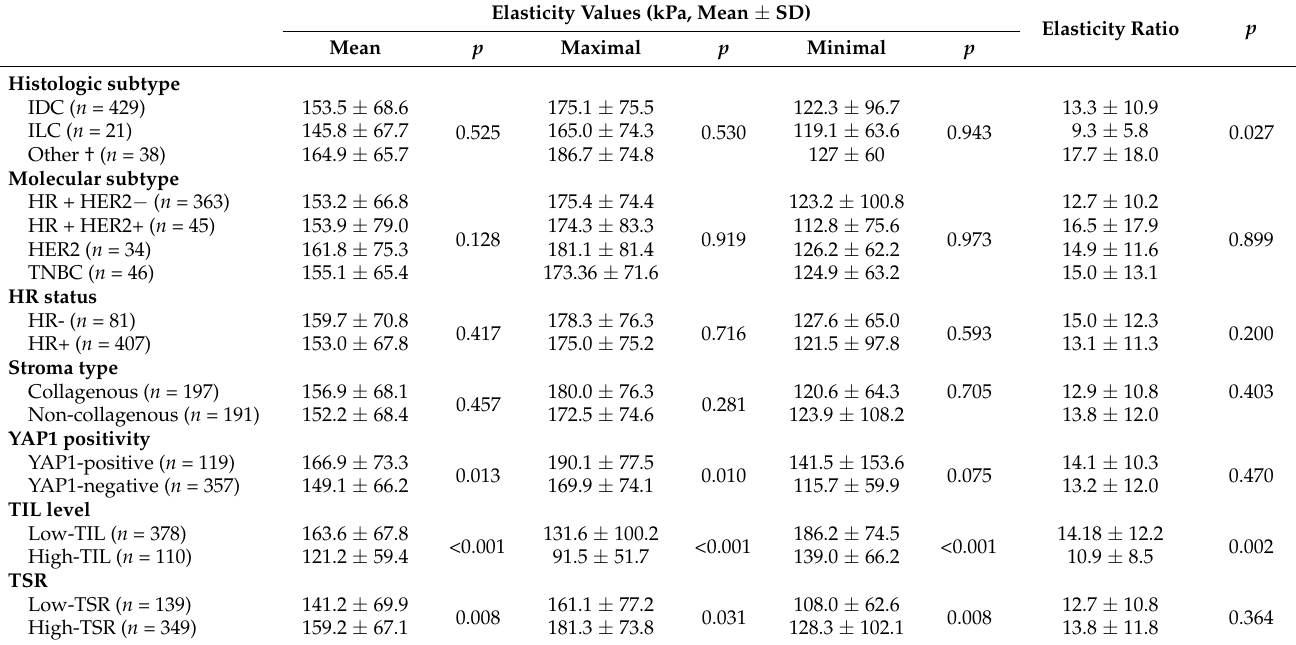
Elasticity Ratio p